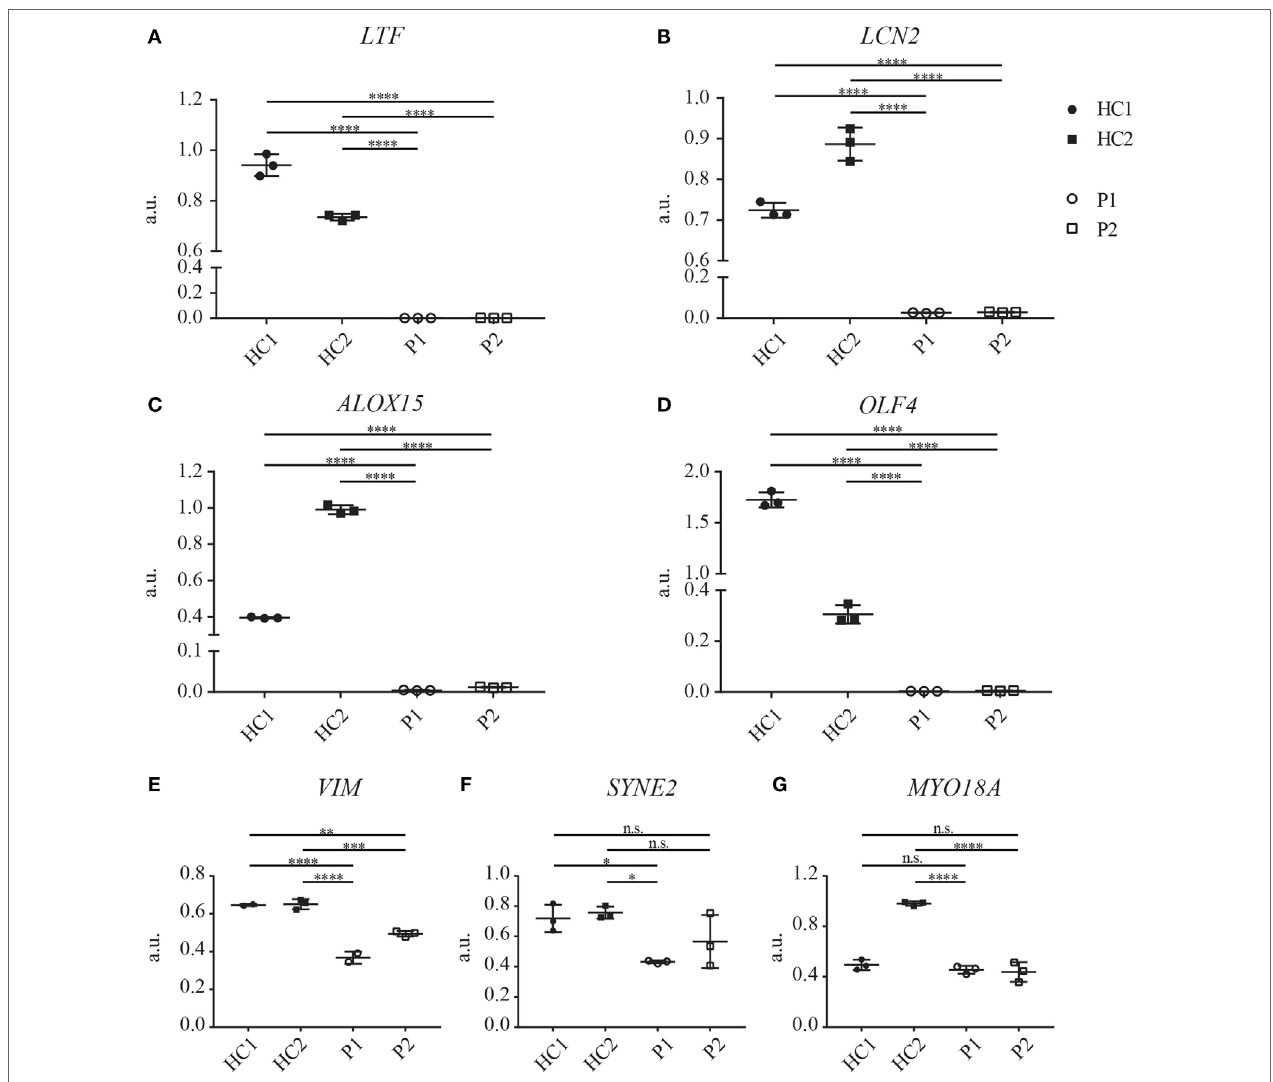
FigUre 5 | mRNA expression of several granule proteins in neutrophils of specific granule deficiency patients is reduced. (a–g) Transcript analysis of LTF (a) , LCN2 (B) , ALOX15 (c) , OLF4 (D) , VIM (e) , SYNE2 (F) , and MYO18A (g) on neutrophils of both patients (P1 and P2) and two healthy controls (HC1, shipment control; HC2, local control, three biological replicates shown). Gene expression was normalized to HPRT1 expression. Significance levels were determined with one-way ANOVA (Bonferroni corrected for multiple